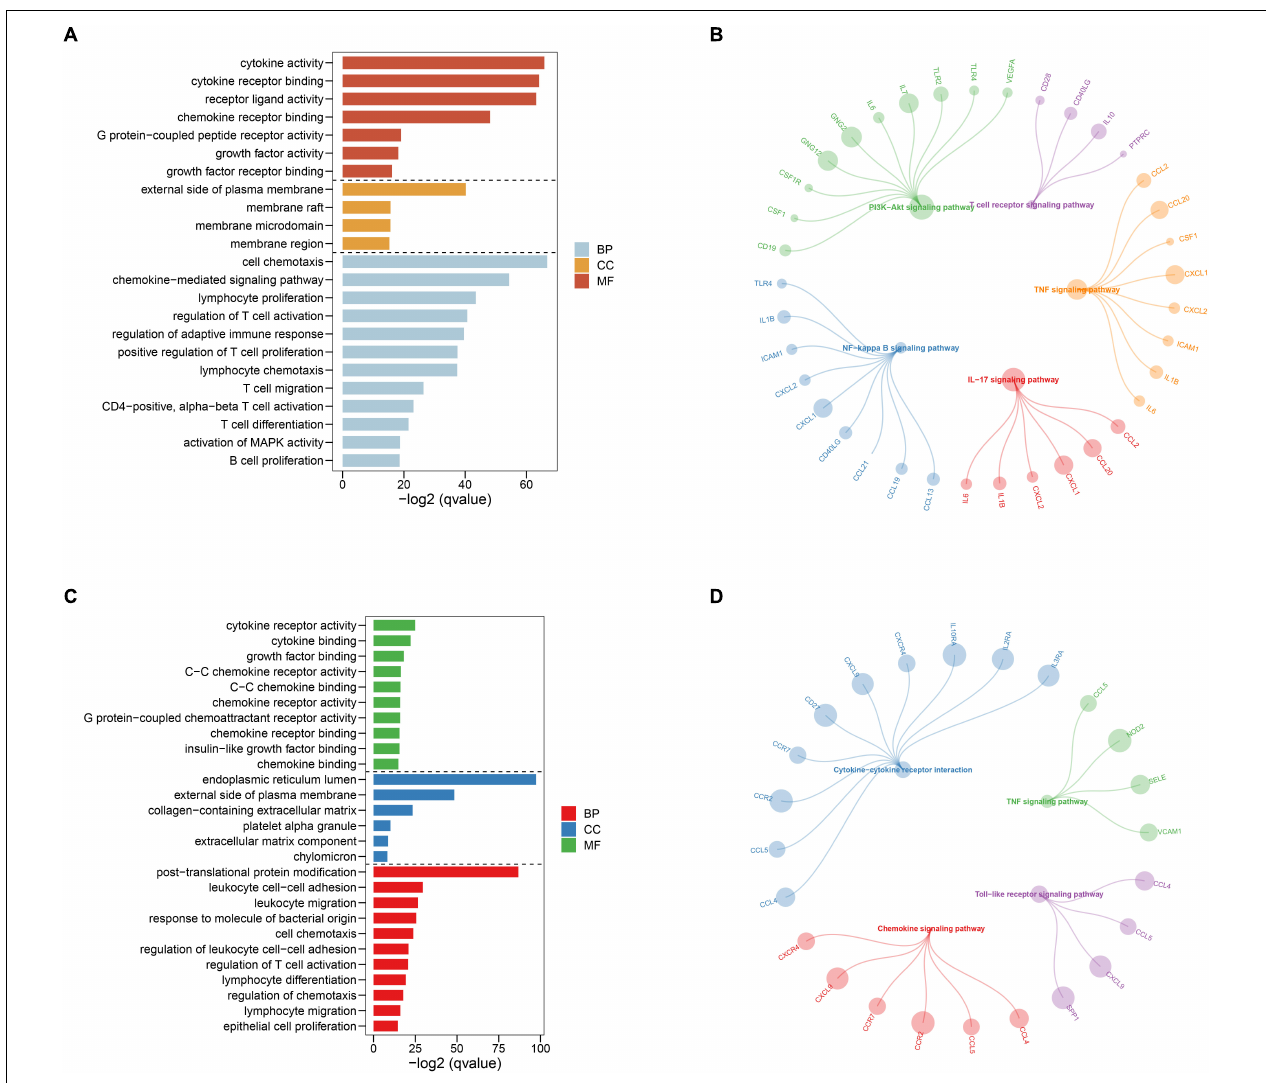
FIGURE 8 | Gene ontology (GO) and Kyoto Encyclopedia of Genes and Genomes (KEGG) enrichment analysis for the first (A,B) and second (C,D) sub networks, respectively.